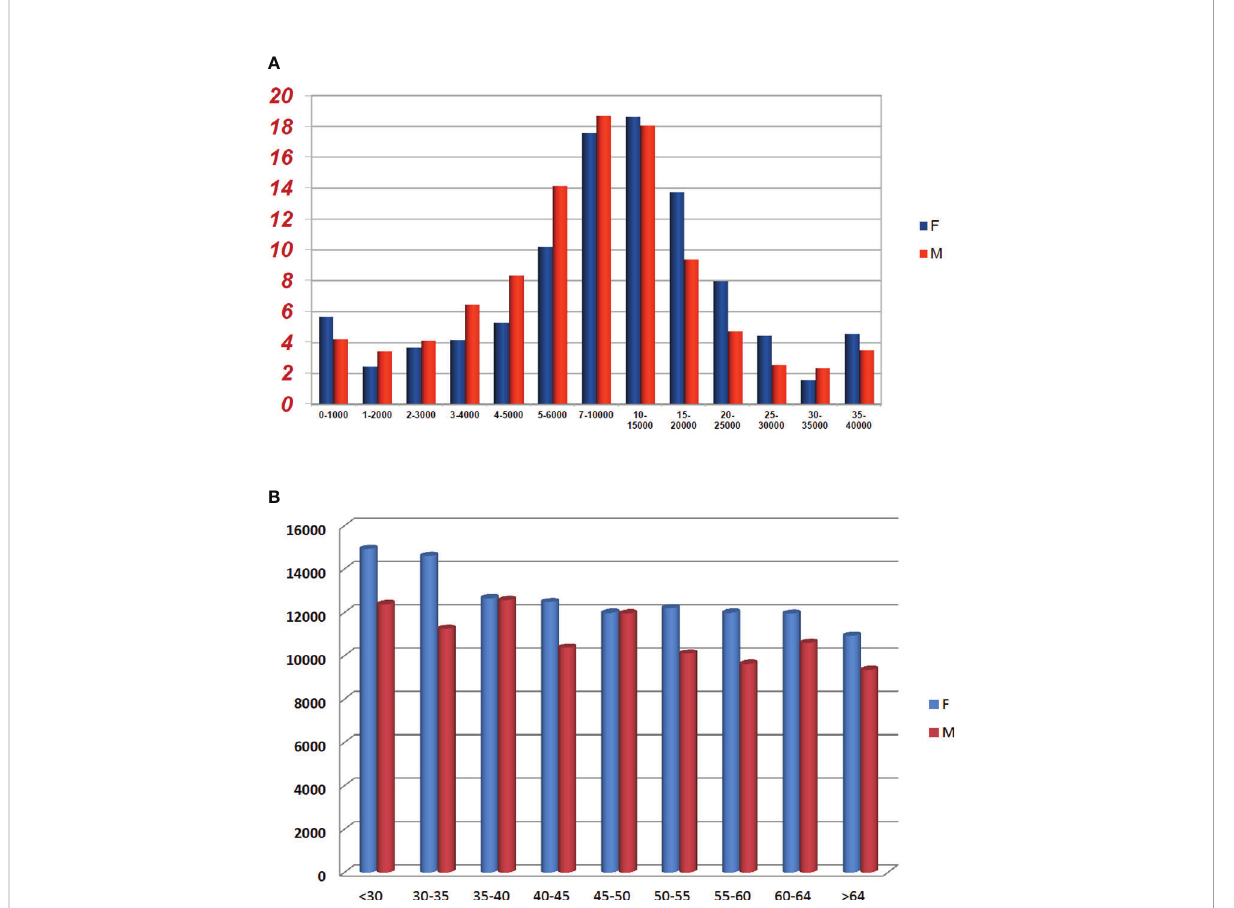
FIGURE 1 Comparison between sexes in the control group according to anti-SARS-CoV-2 concentrations (A) and age (B) . (A) Proportion of healthy subjects by sex and different IgG anti-SARS-CoV-2 concentration (AU/mL × 10 3 ) groups. (B) IgG anti-SARS-CoV-2 mean concentration strati fi ed by sex and age